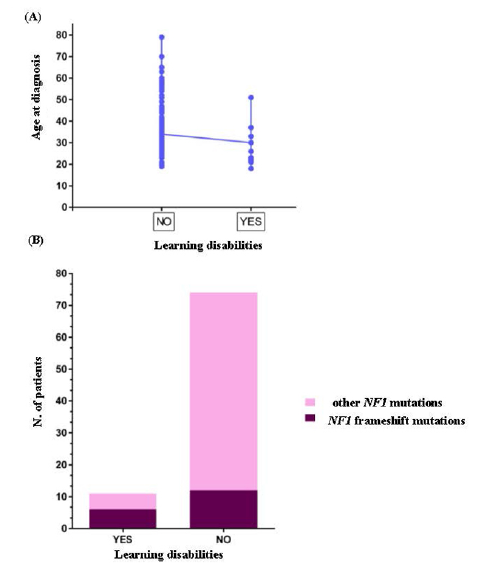
Figure 2. ( A ) Correlation analysis in the NF1 patients. Graph showing an inverse correlation between the presence of learning disabilities and age at diagnosis. ( B ) Odds ratio analysis. Odds ratio with 95% CI revealed a higher probability to have learning disabilities in NF1 patients carrying frameshift mutation in the NF1 gene.